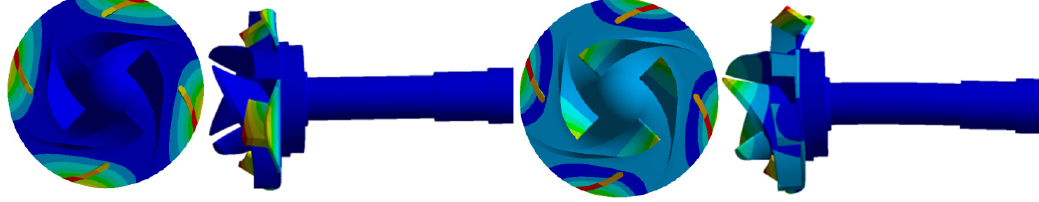
Figure 16. Fore eight modes of case